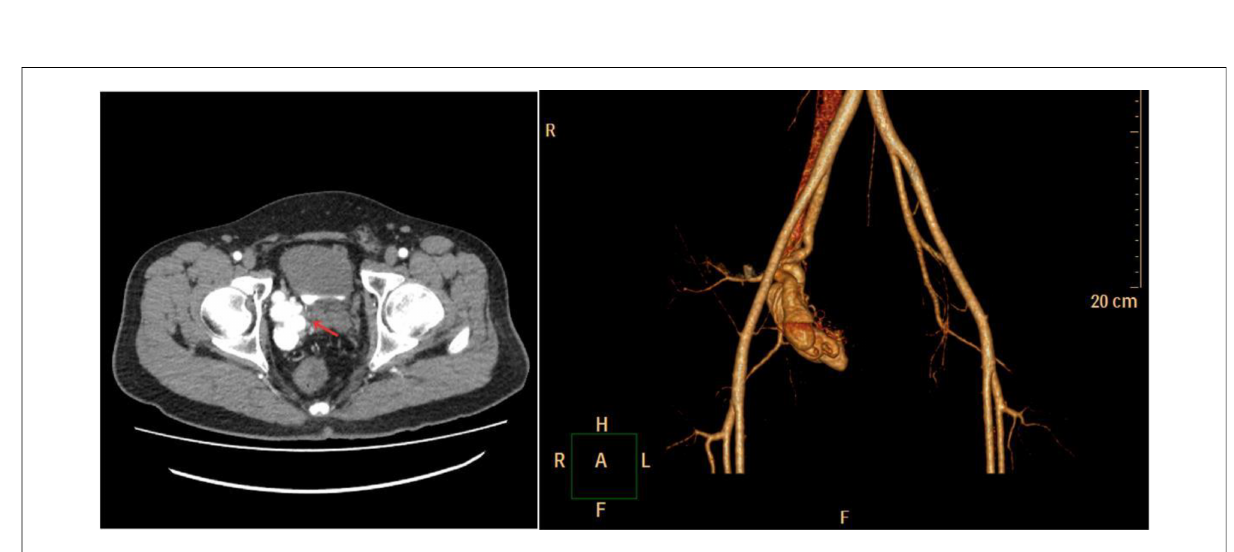
FIGURE 2 Computed tomographic angiography showed a large pelvic arteriovenous malformation (red arrow) supplied mainly by the right internal iliac artery.